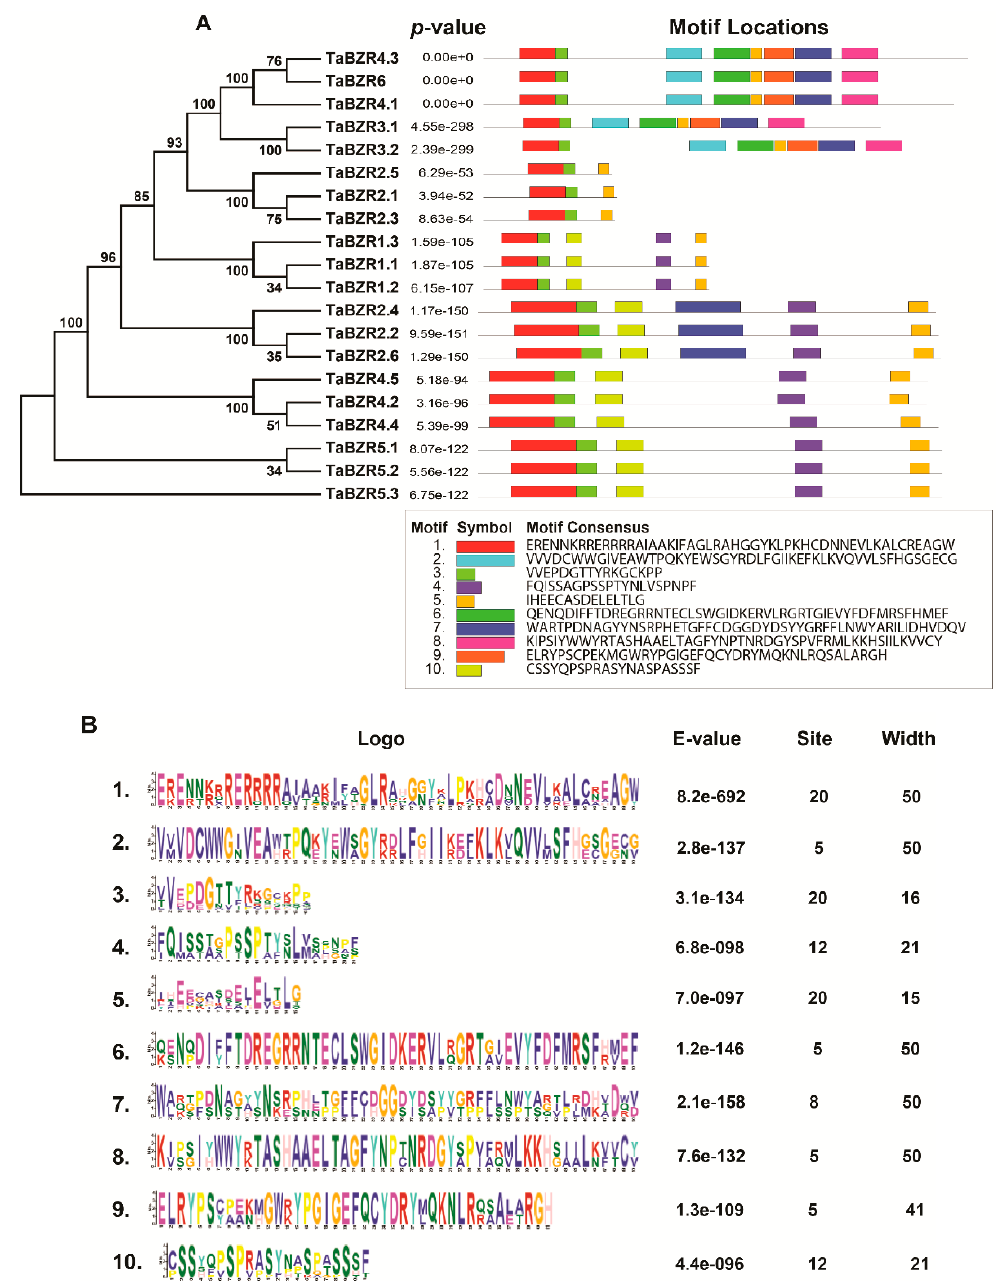
length. The exon and intron sizes can be estimated using the scale at the bottom.